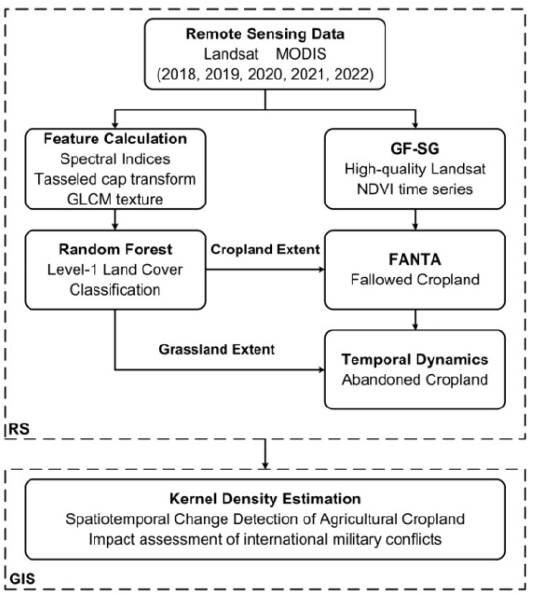
Figure 2. Flowchart of mapping agricultural land, analyzing the spatiotemporal change of agricultural cropland and assessing the war impact.